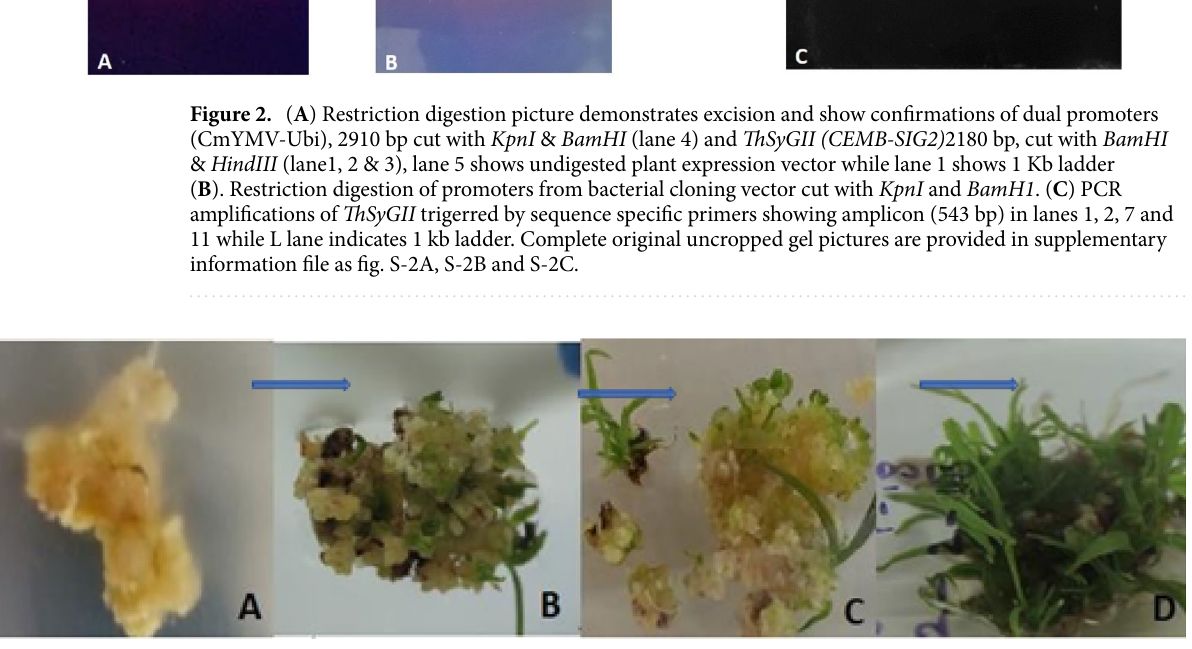
Figure 3. ( A ) Putative ThSyGII embedded calli shifted to MS media plates nourished with auxins and cytokinins ( B ) Calli initiated regeneration after 7 days of 28 °C 16 h light and 8 h dark conditions ( C ) Regeneration of putative transgenic calli after 14 days ( D ) Shoots appeared with capacity after 30 days of media nourishments.All full length original uncropped figures are provided in the supplementary information file as figure S-3A, S-3B, S-3C and SIP31, SIP34, SIP36, SIP37, SIP40, SIP41, SIP45, SIP46 and SIP48 survived indulging in selection media.The phenotypic data confirmed their resistance against hygromycin drug and could be seen in good health condi- tions. Figure 4A illustrated transgenic lines positive for ThSyGII gene construct. Similarly, Fig. 4B represented all transgenic plants grown under zero selection media and were shown inoptimum plant growth without the death of any single plant. Similarly, after 3 months, transgenic and control plants were shifted to field conditions as shown in Fig. 4C,D. Putative transgenic sugarcane lines show PCR amplifications and dot blotting indicating the integration of ThSyGII (CEMB‑SIG2) . The figure 2C indicates the integration of PCR amplicon with 543 bp product size amplified byprimer specific sequences. The Fig. 5A,B showed in lanes 10 &11 negative sugarcane lines having no integration of transgene while clear bands at 543 bp showed the presence of ThSyGII (CEMB-SIG2) . Transgene ThSyGII exhibited triggered diversified pattern of expression levels in transgenic Saccharum officinarum lines. Real Time PCR experiment of PCR positive sugarcane lines showed vali- dation and produced expression profiles in transgenic lines. The transgene expression levels represented the activity levels of ThSyGII in different tissues ofplant. Our results showed that ThSyGII expressed tremendously in sugarcane leaves. The transgenic lines SIP34, SIP36 and SIP41 were graded at highest levels with 4.2, 3.9 and 3.8 fold expressions respectively than control lines. The ThSyGII transgenic lines SIP37, SIP48 and SIP40 exhibited 3.2, 3.0 and 2.8 times more expression respectively than control lines considered being at middle level. Moreover, remaining sugarcane lines SIP31, SIP45 and SIP46 could only indicate 2.1, 2.3 and 2.2 fold expression of ThSyGII respectively to control lines (Fig. 6A). The expression level of ThSyGII indicated expression profile obtained from stem tissues were extremely encouraging. The Fig. 6B indicated that transgene expression in stem tissues in